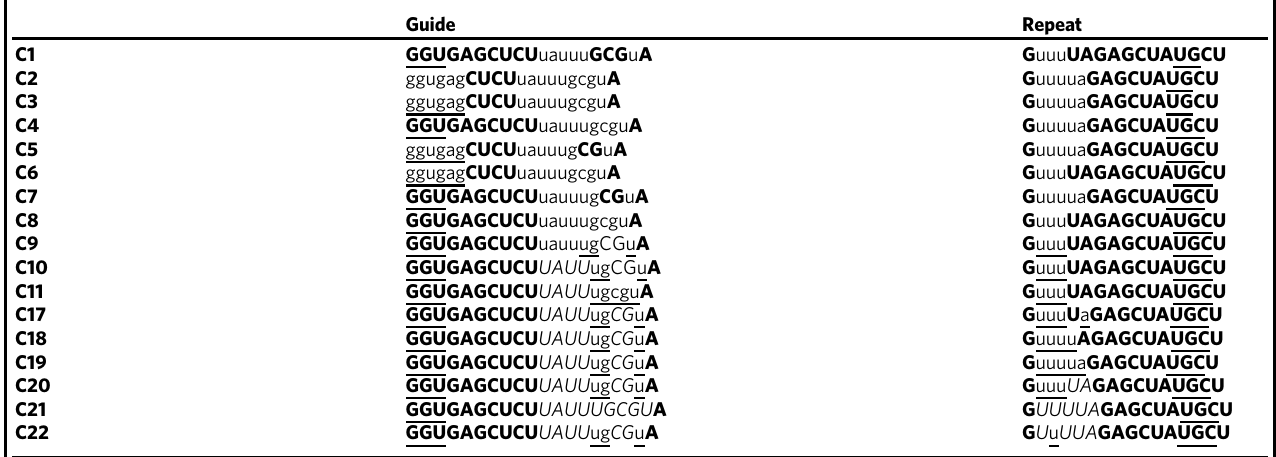
Table 1 Chemically modi fi ed crRNAs used in this study Guide Repeat